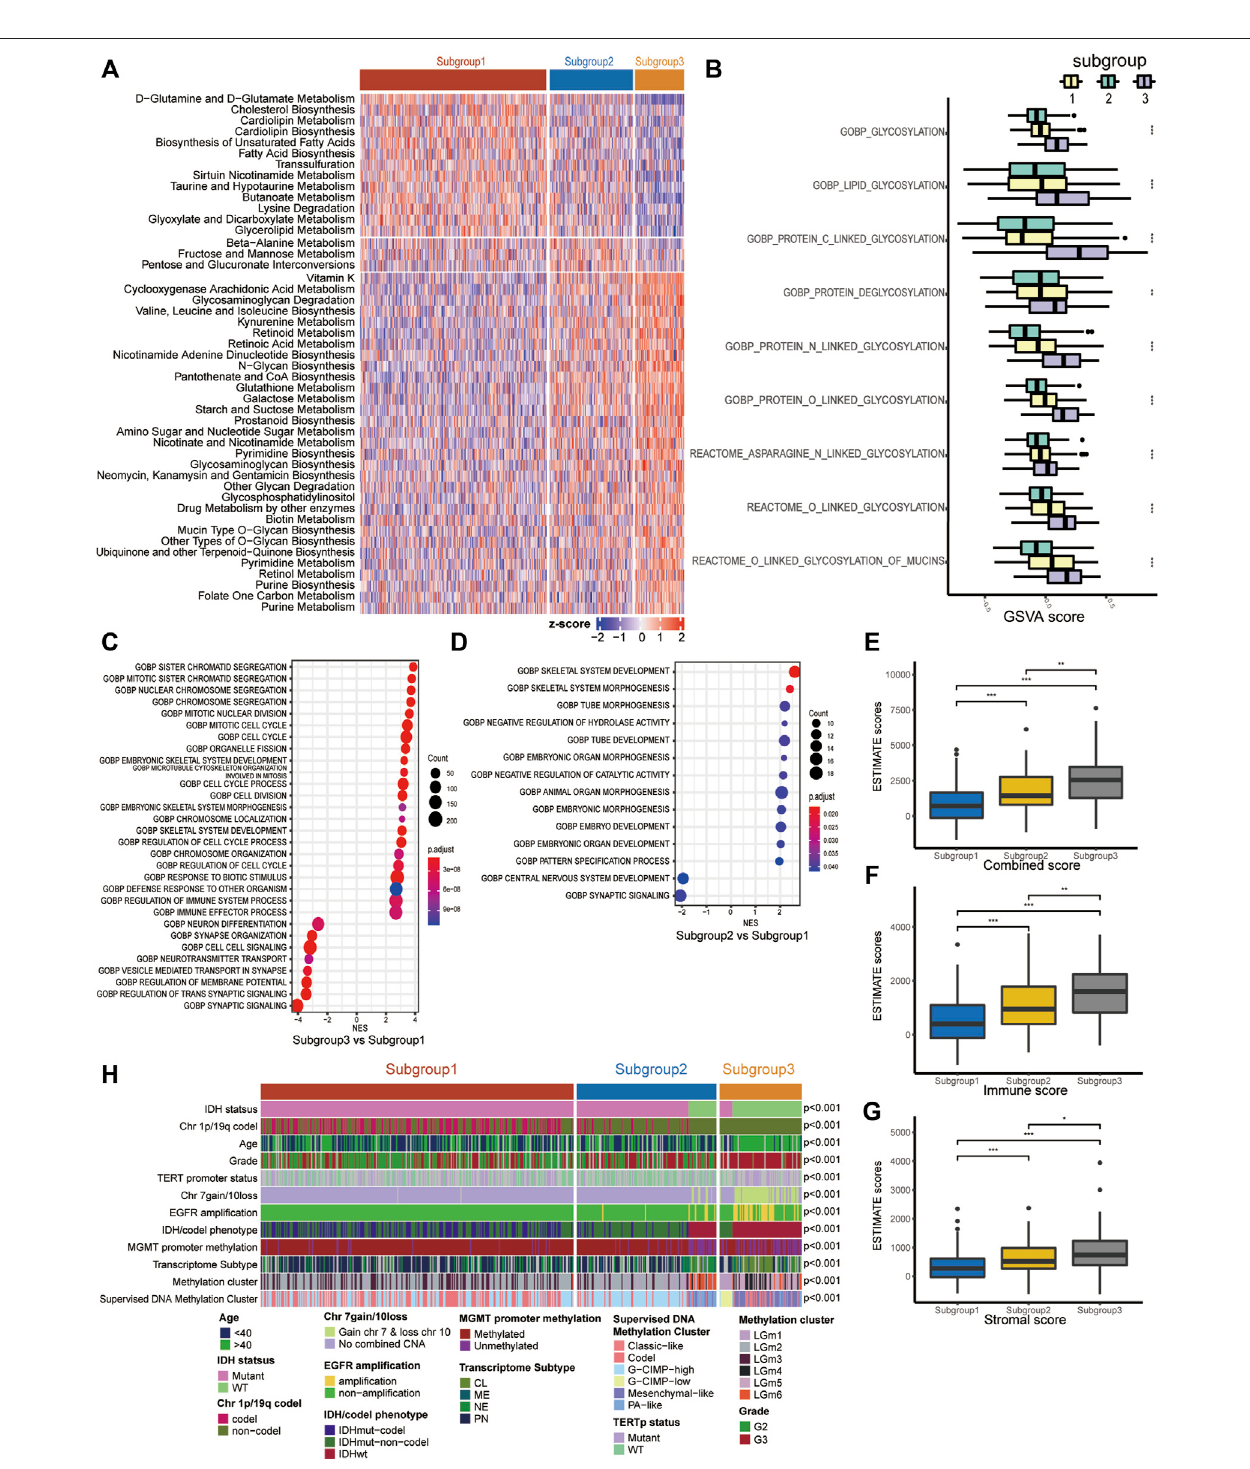
FIGURE2| Molecular characteristicsofthethree LGGsubgroups. (A) Heatmap ofthesubgroup-speci fi cmetabolic signatures. (B) BoxplotoftheGSVA scoresof glycosylation processes. (C,D) Dotplot of functional analysis using GSEA. (E – G) Boxplot of the combined score, immune score and stromal score estimated using ESTIMATE. (H) Correlation of our subgroups with common clinical features/molecular subclasses. ns represents no signi fi cance, * p < 0.05, ** p < 0.01, *** p < 0.001.